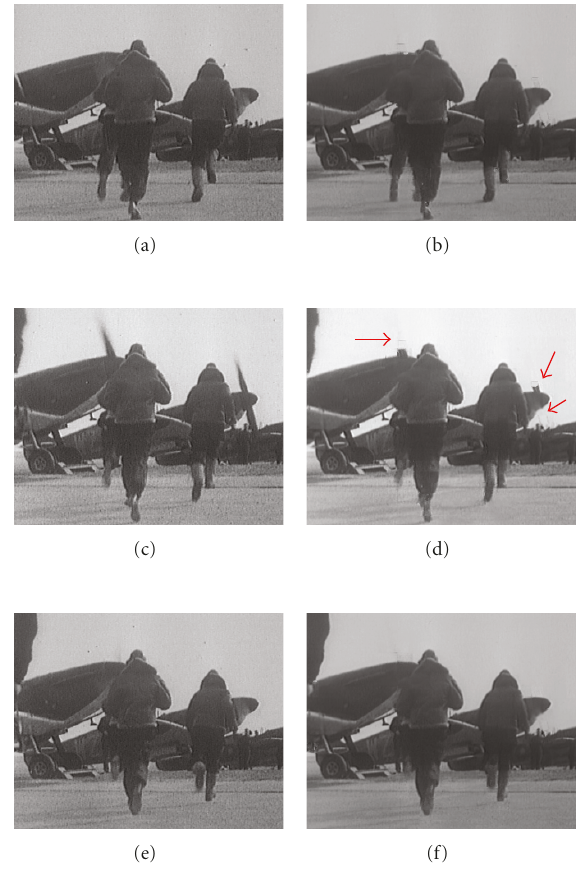
Figure 1: Left: three consecutive frames of a sequence where the motion of the propellor blades is PM (repetitive occlusion); right: the images after MDT using [10]. The arrows indicate the removal of the blades due to the blades being misdiagnosed a blotch.